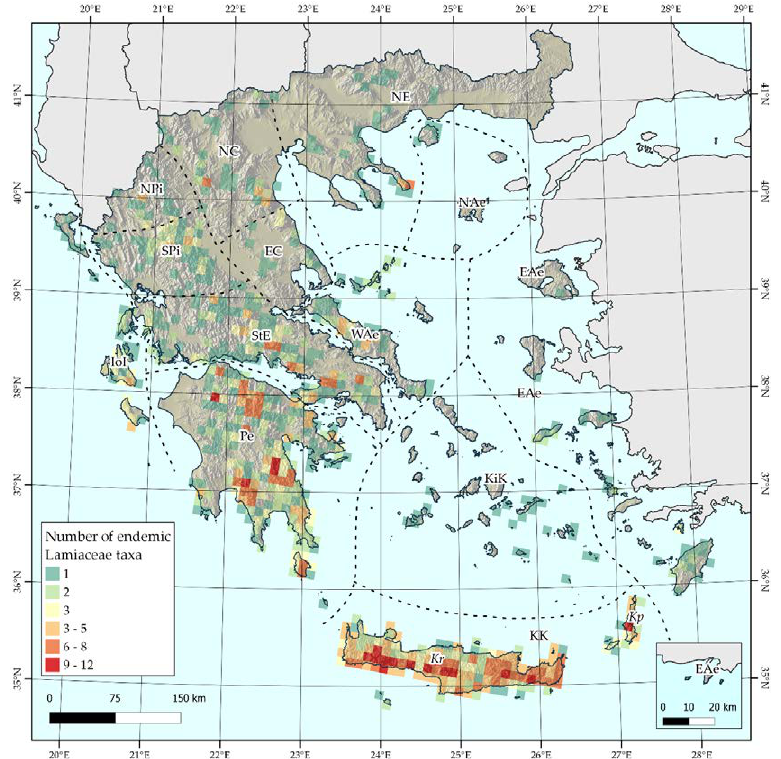
Figure 4. Distribution of the endemic Lamiaceae taxa in Greece (10x10 km, EEA reference grid). Dotted lines delineate the floristic regions of Greece